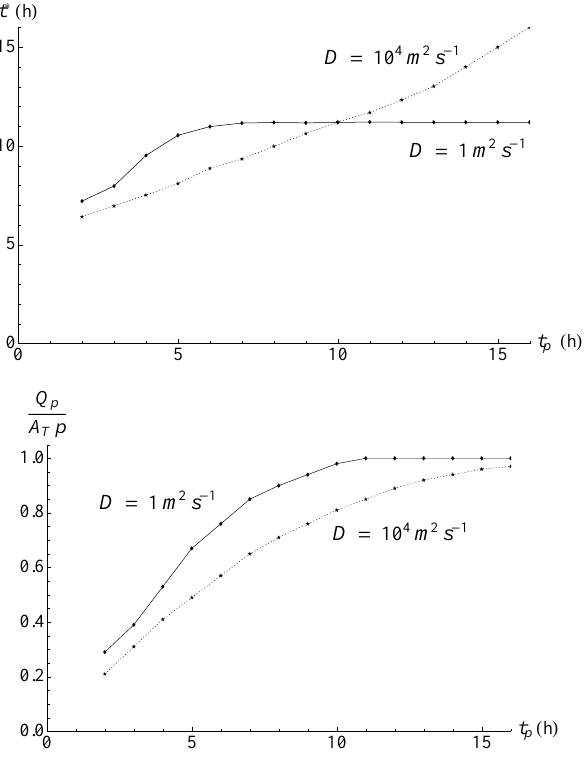
Fig. 6. (top) Time to peak ( t ∗ ) and (bottom) normalized peak flow values as a function of the rainstorm duration ( t p ) in the Salt River